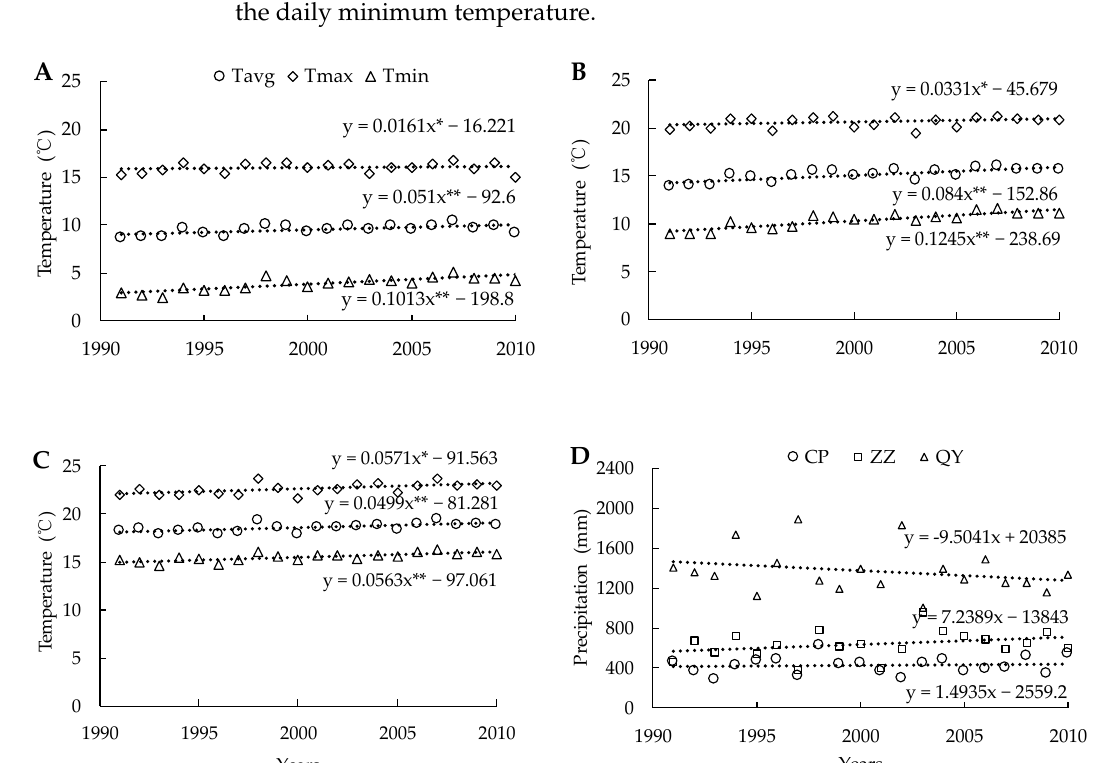
Figure 1. Historical trends of annual average, maximum, minimum temperatures and precipitation in the three experimental sites during 1991–2010. Straight lines are the linear regression lines. ( A ) Changping, ( B ) Zhengzhou, ( C ) Qiyang, ( D ) The historical trends of precipitation. ** Significant at p < 0.01; * significant at p < 0.05.